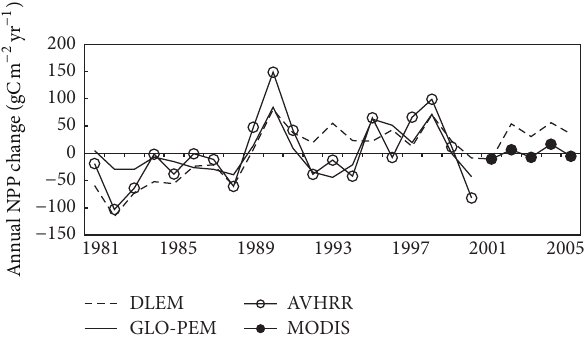
Figure 3: Temporal change in annual net primary production (NPP) (relative to the average for 1981–2005) of China’s croplands estimated by DLEM-Ag model, GLO-PEM model, AVHRR, and MODIS database during 1981–2005) (modified from Ren et al.